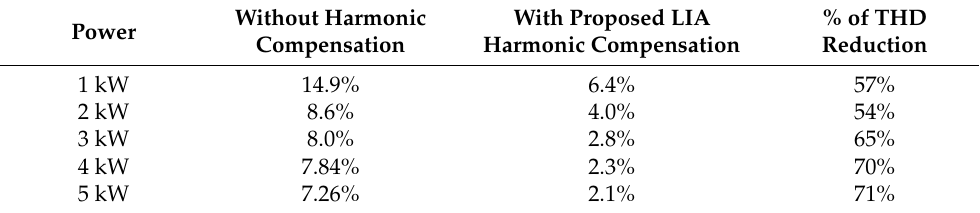
Table 3. THD reduction by the proposed harmonic compensation